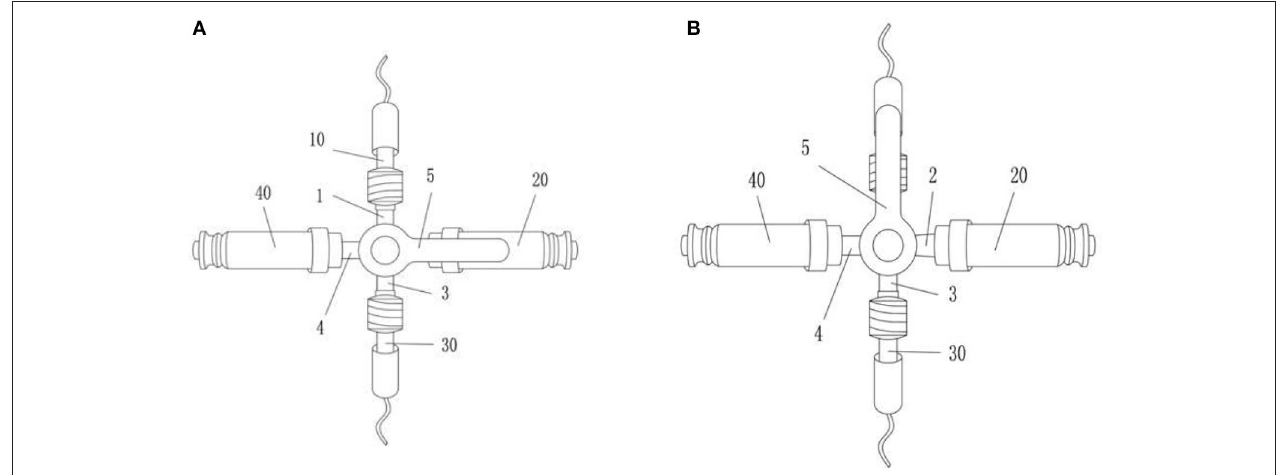
FIGURE 2 | The improved invasive blood pressure monitoring pipeline valve. The improved invasive blood pressure monitoring pipeline valve includes four interconnected pipeline branches (1, 2, 3, 4) and a valve switch (5) that controls the opening and closing of the pipeline branches; the first pipeline branch ( 1) is connected to the arterial catheter (10), the second pipeline branch (2) is equipped with a pressure sensor screw cap (20), the third pipeline branch (3) is connected with the pressure sensor pipeline (30); the fourth pipeline branch (4) is equipped with a positive-pressure connector (40). When in use, the monitor connected to the pressure sensor needs to be reset to zero, whereas the second pipeline branch (2) is normally closed (A) ; for zeroing operation, the valve switch is first turned to the first pipeline branch (B) ; at this time, the first pipeline branch is closed, and the pressure sensor path of the monitor is connected to the air and atmospheric pressure. When the monitor reset button is pressed, and the monitor value shows 0, the valve switch turns to the second pipeline branch (A) . At this time, the first pipeline branch, the third pipeline branch, and the fourth pipeline branch are connected, and the second pipeline branch is closed; when blood is collected, the syringe nipple is directly connected to the positive-pressure connector to draw blood.